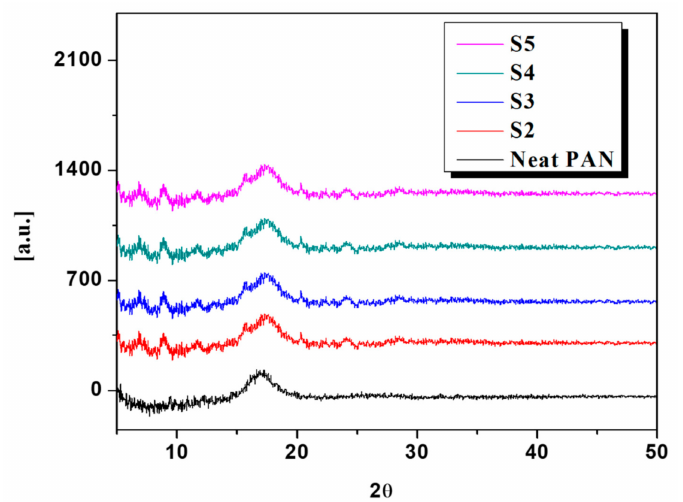
Figure 2. XRD diffractograms of neat (S1) and DLF loaded PAN nanofibers (S2, S3, S4, and